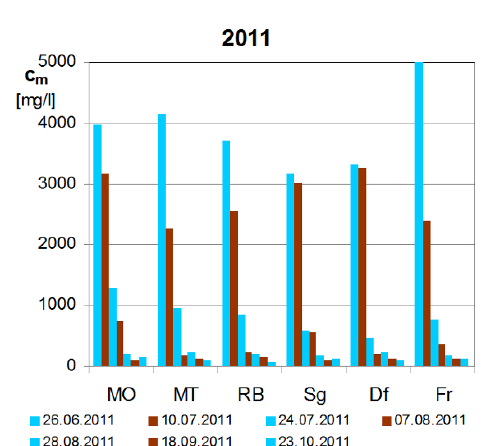
Figure 8. Total content of phenolic compounds in grape juice of the grapevine varieties: Muscat Ottonel (MO),